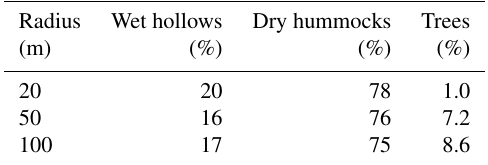
Figure 4. Distribution of dry and wet areas in Mycklemossen ac- cording to microtopography. The black triangle indicates the sam- pling location of measurements used for the nocturnal boundary- layer accumulation (NBLA) approach. The chambers were situated along the boardwalk (red line). Black circles indicate the distances (20, 50, 100m) from the NBLA sampling point. Table 2. Proportions of different vegetation types in different radii around the NBLA